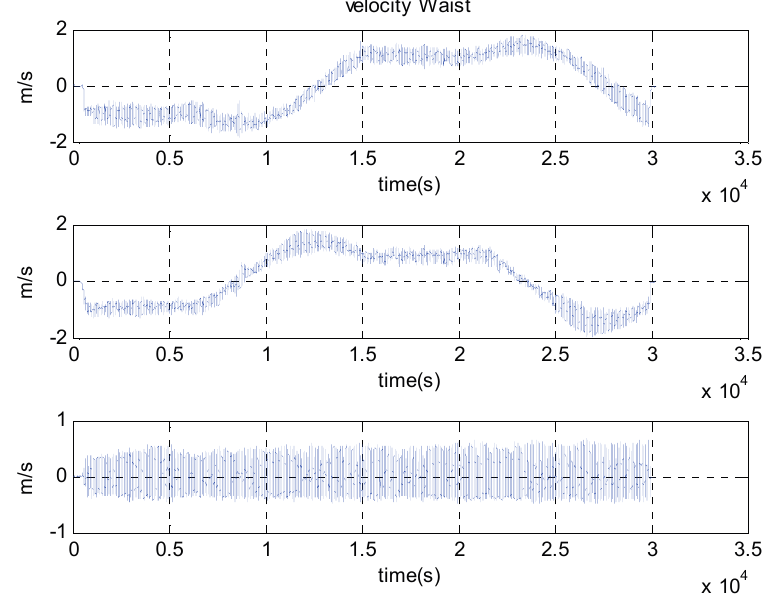
Figure 19. Results of estimated velocity of waist in NED frame during long distance trajectory